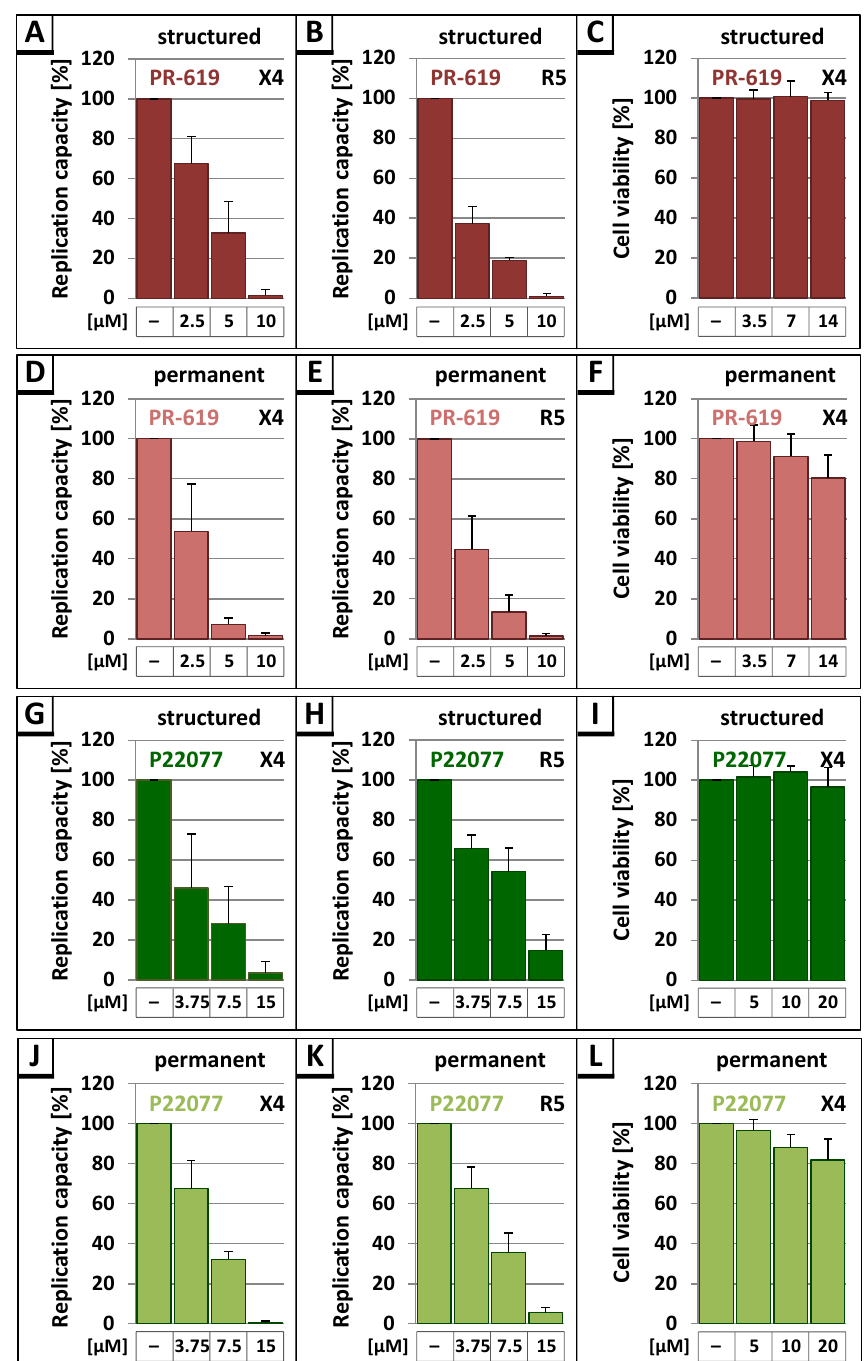
Figure 5. Treatment with the DIs PR-619 and P22077 leads to a concentration-dependent reduction of the replication capacity of HIV-1 in HLAC, irrespective of treatment scheme and cell tropism. ( A , B , D , E , G , H , J , K ) Following infection of HLAC with X4- and R5-tropic virus (1ng p24), structured and permanent treatment with 2.5 μM, 5 μM, or 10 μM PR-619 or 3.75 μM, 7.5 μM, or 15 μM P22077 respectively, was performed. The replication capacity of HIV-1 NL4-3 was assessed by calculating the area under the curve (AUC) from each individual replication profile. The replication capacity of untreated HIV-1 NL4-3 in each experiment was set to 100%. Bars represent the mean values of 3 ( A , B , D , G , H , J ) or 4 ( E , K ) independent experiments ± SD. ( C , F , I , L ) Cell viability was assessed by water-soluble tetrazolium salt (WST)-1 assay. HLAC were infected with X4- and R5-tropic virus (1ng p24), followed by structured and permanent treatment with 2.5 μM, 5 μM, or 10 μM PR-619 or 3.75 μM, 7.5 μM, or 15 μM P22077 respectively. Untreated, HIV-1 NL4-3 infected cells were set to 100%. Bars represent the mean values of 8 independent experiments ± SD.